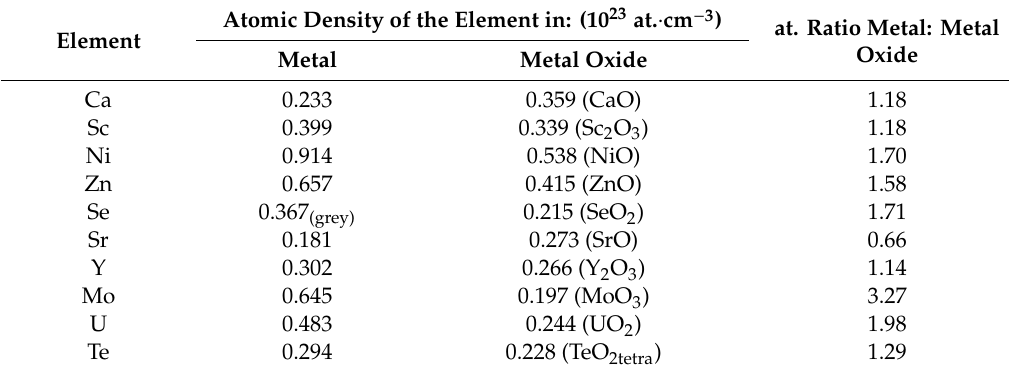
Table 2. Atomic densities of the elements in metals and their oxides. Atomic Density of the Element in: (10 23 at. · cm − 3 ) at. Ratio Metal: Element